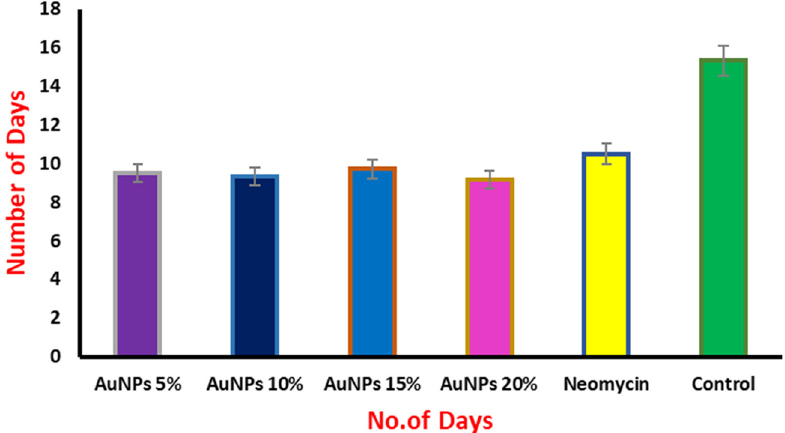
Figure 7: E ff ect of AuNPs on period of epithelialization in thermal wound